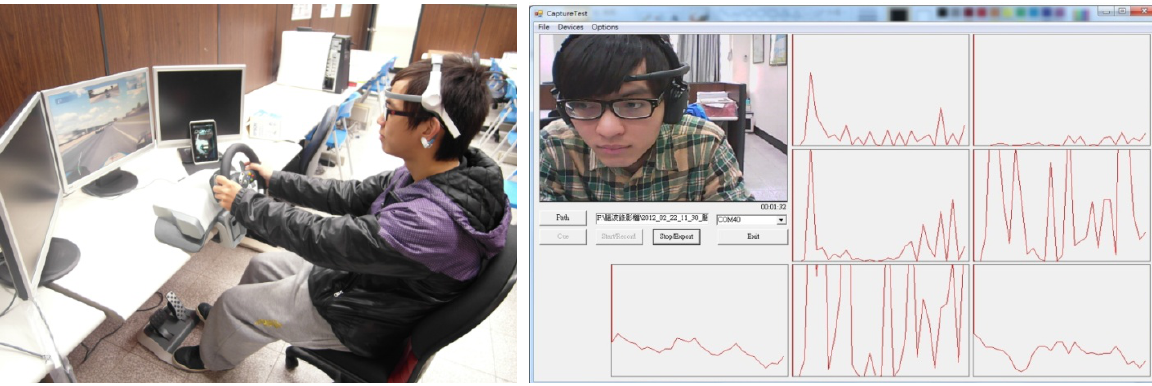
Figure 7. A driving simulation system for the collection of driver’s